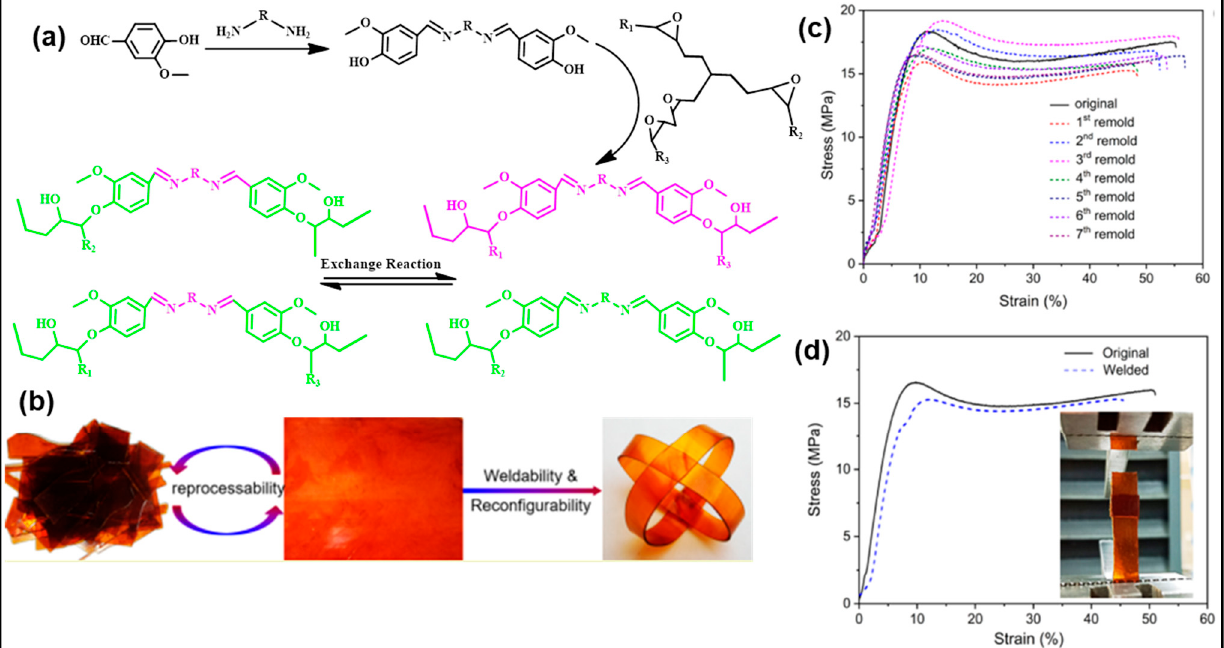
Figure 17. ( a ) Preparation of fully bio-based vitrimers from ESO and vanillin modified (VSB) hardener and its exchange reaction; ( b ) reprocessability and weldability, ( c , d ) mechanical strength of pristine and remolded or welded samples [reproduced with permission from Zhao et al.; pub- lished by ACS, 2020] [81].